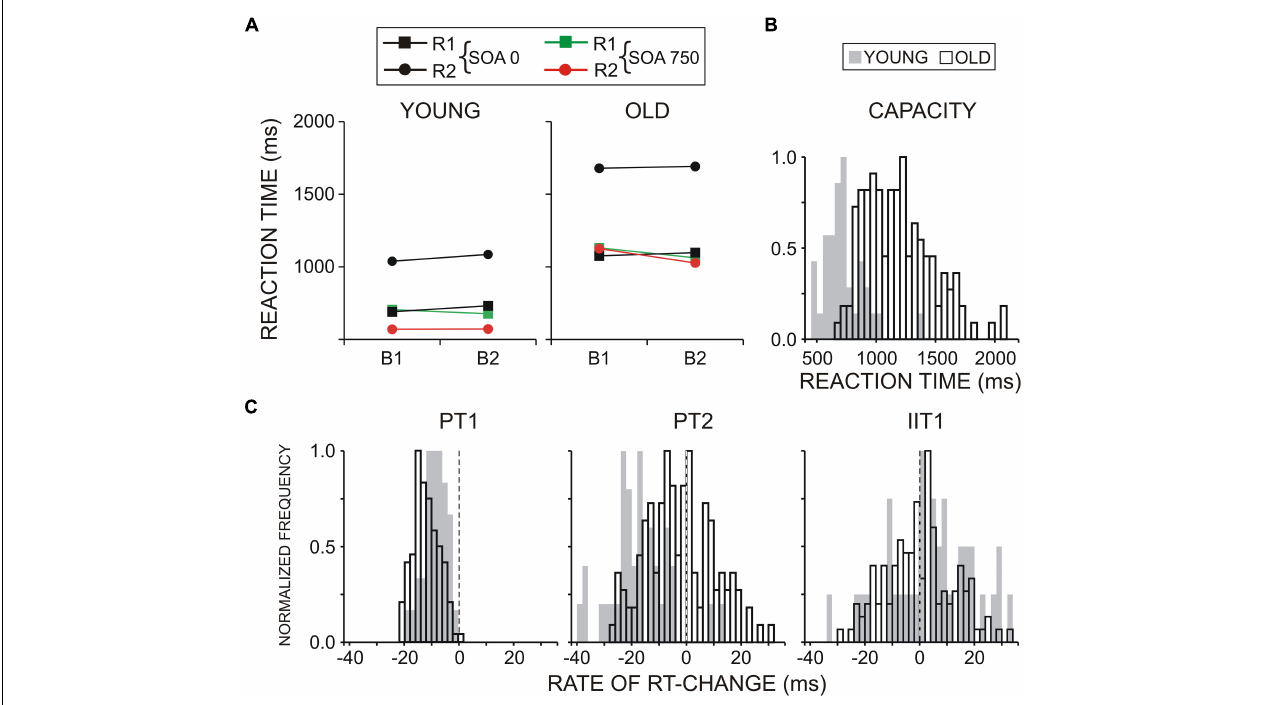
FIGURE 2 | (A) Reaction time (RT) for two groups of participants, young and old. (B) Normalized distribution of Capacity parameter for both groups of young and old adults. Capacity: speed of processing in the dual-task blocks as reflected by the mean RT to S1 and S2 in two SOA conditions (SOA750 and SOA0), in two blocks (B1-LC and B2-CL). (C) Normalized distribution of dual-task preparation parameters: preparation for T1 (PT1), preparation for T2 (PT2), and input interference for T1 (IIT1), presented for young and old subjects.